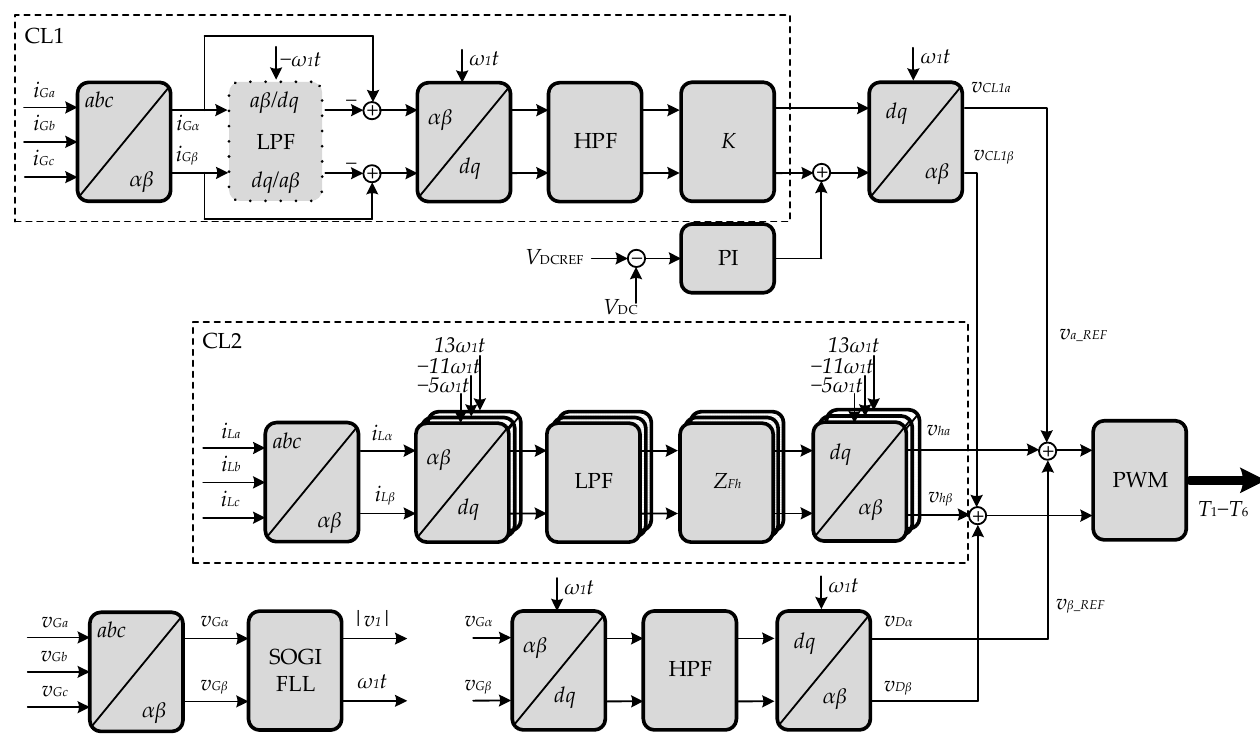
Figure 4. The control system of the proposed hybrid active power filter. For better filtering effect, the transformation to a negative sequence rotating coordinate system can be used, as is presented with dotted line in Figure 4. After that, the required signals are gained with K factor and transformed to stationary coordinate systems α , β . It should be mentioned that this part of control algorithm operates as a closed loop control with the feedback and the value of the gain K is limited because of the possibility of control instability, which is presented in the next